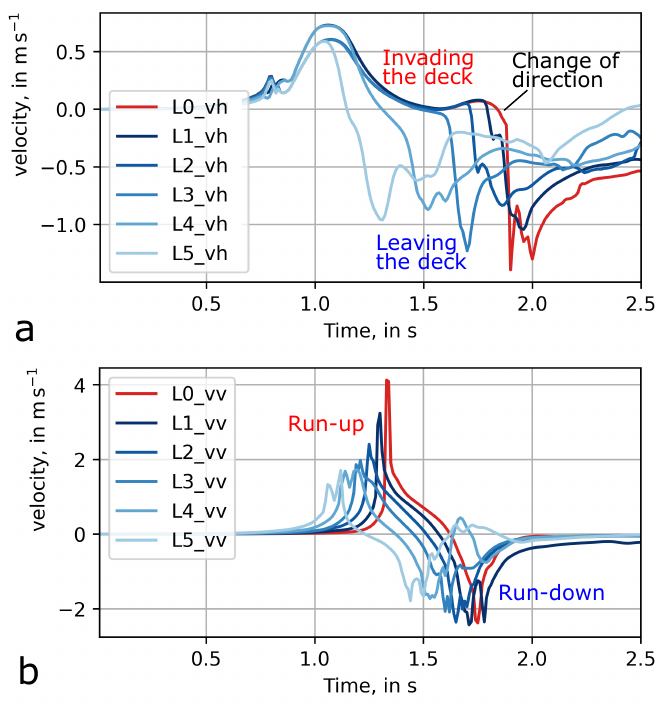
Figure 11. Effect of deck length on shipping water velocities. ( a ) Time series of horizontal velocity ( v h ) at the deck edge for different deck lengths. ( b ) Time series of vertical velocity ( v v ) close to the deck wall for different deck